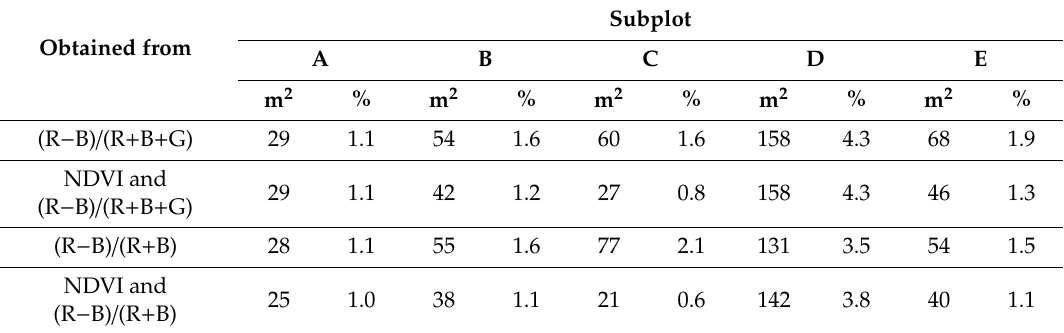
Table 2. Estimation of surface infected with Synapis arvensis in each of the alfalfa subplots for the two RGB vegetation indices and for their combinations with the Normalized Di ff erence Vegetation Index (NDVI).